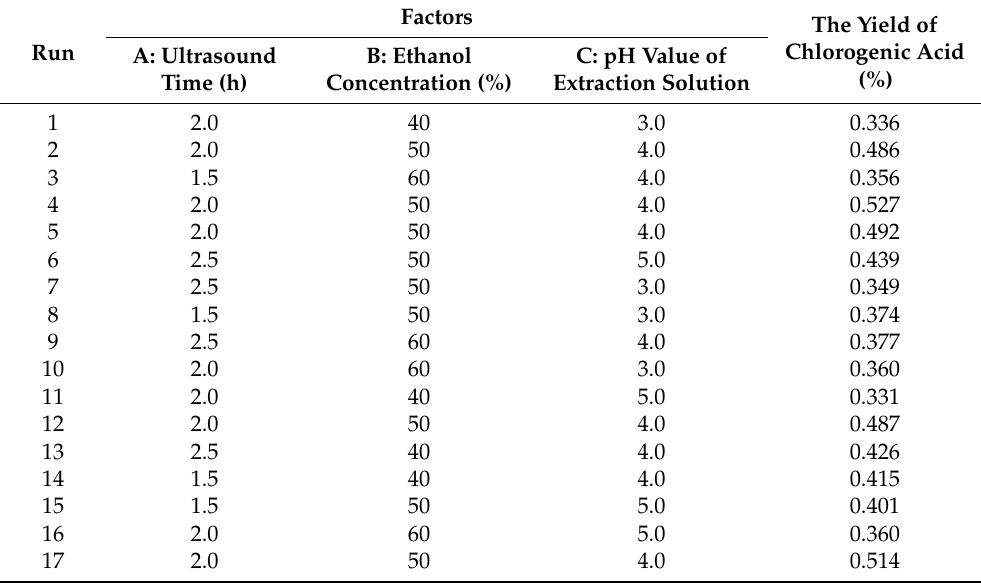
Table 1. Response surface analysis and